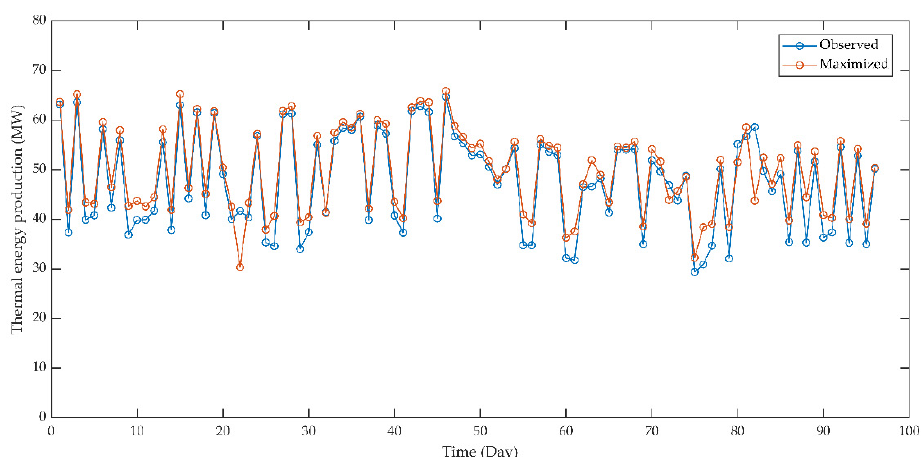
Figure 18. Observed and maximized values of thermal energy production.